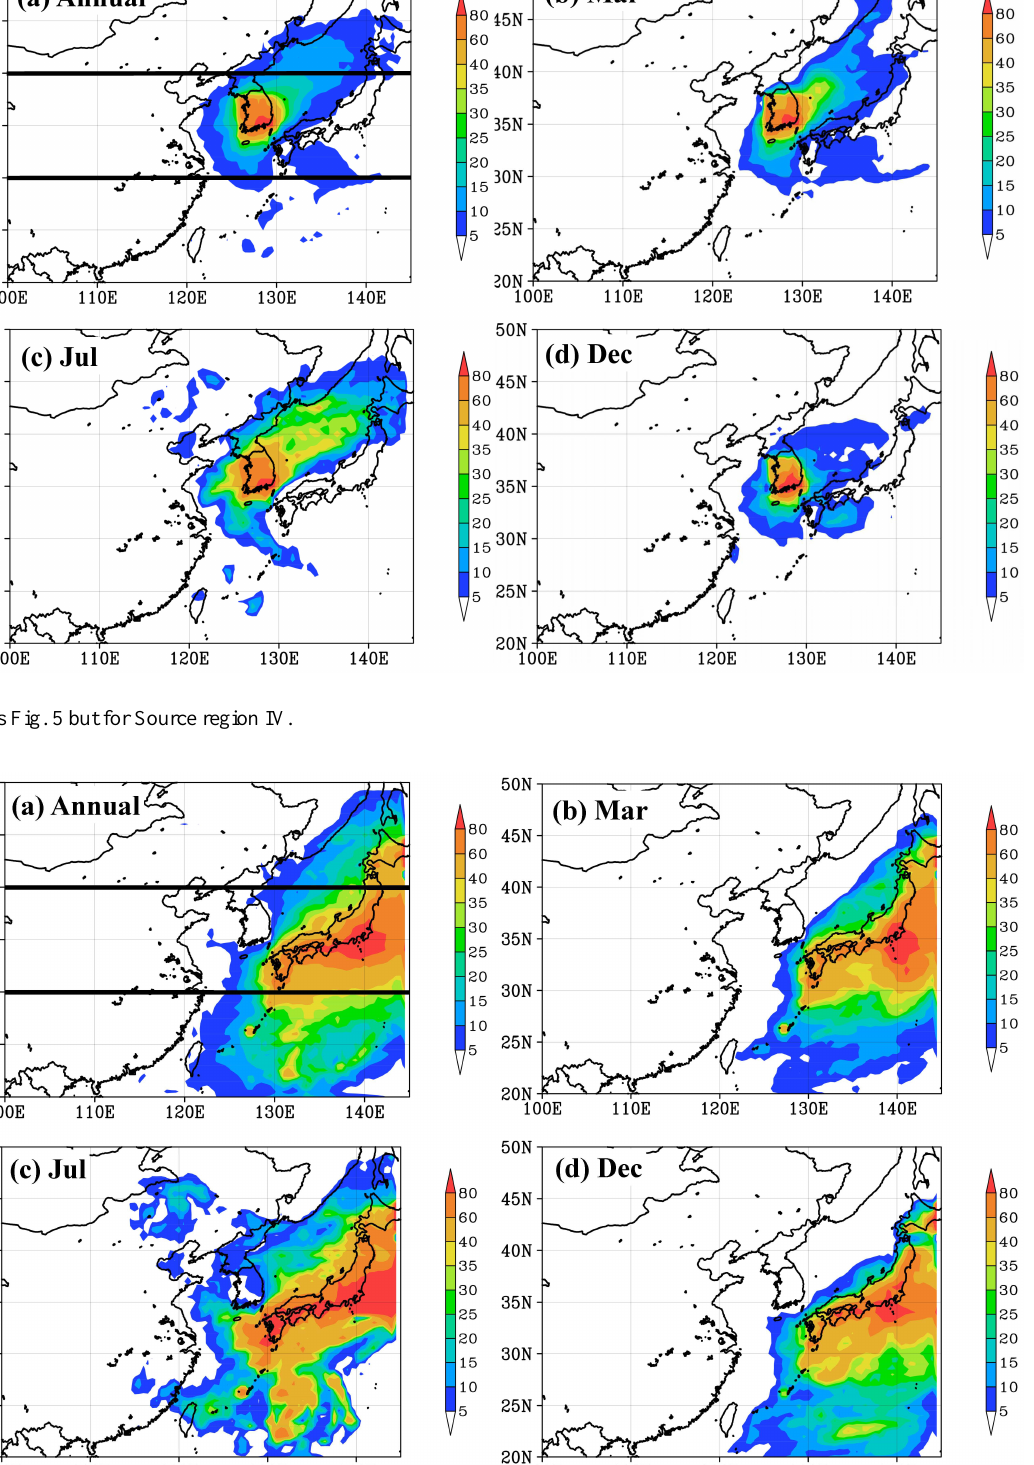
Fig. 9. Same as Fig. 5 but for Source region